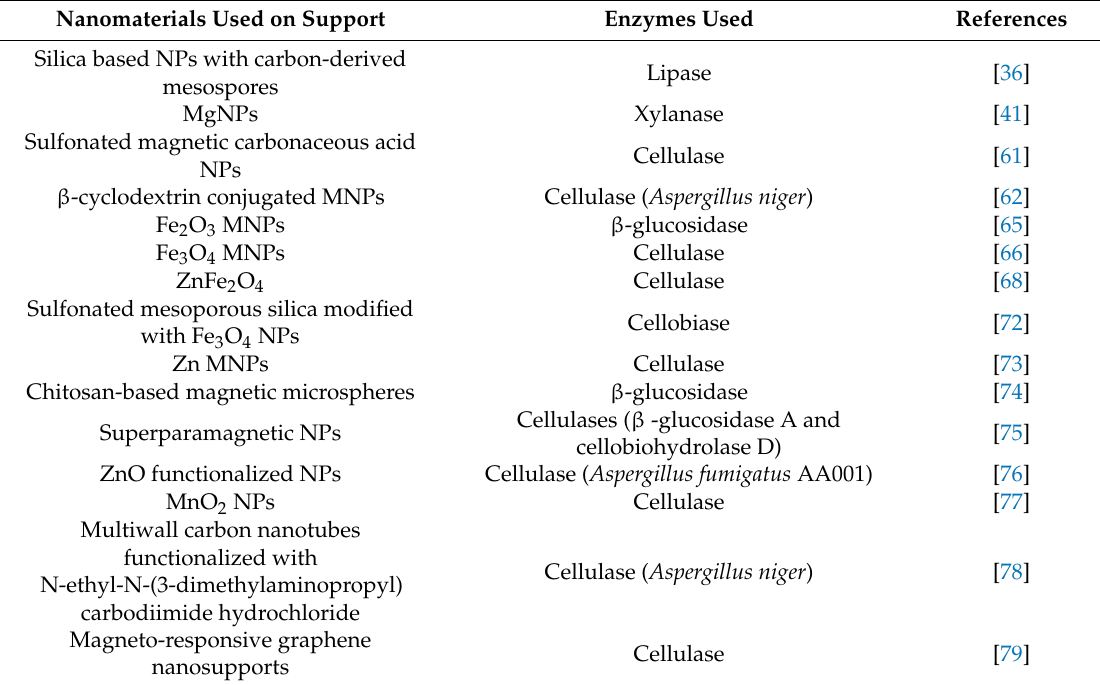
Table 1. Various nanomaterials used for immobilization of di ff erent